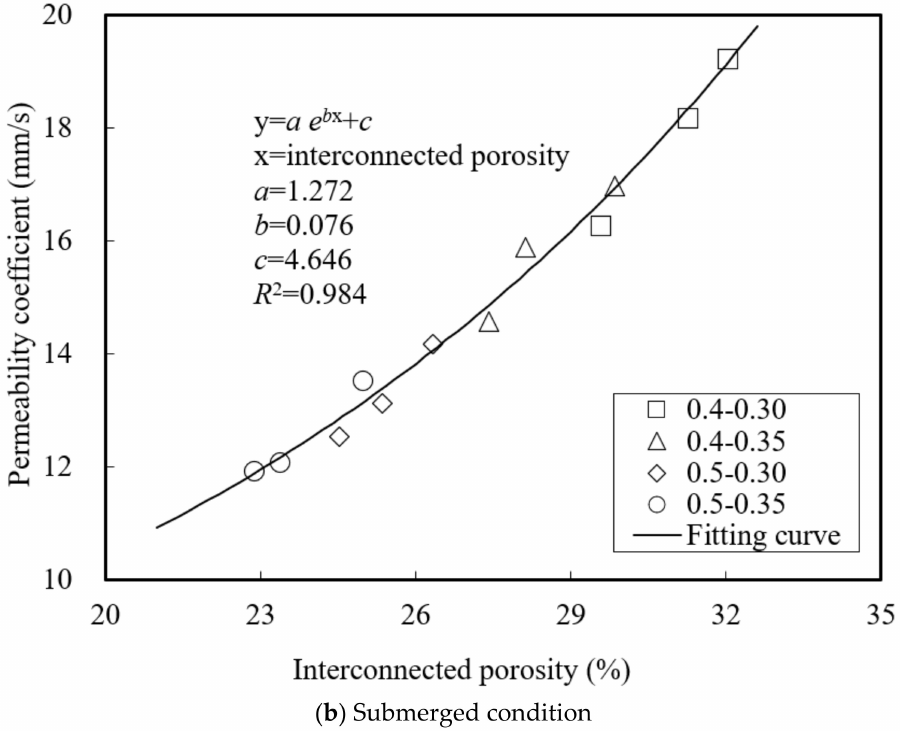
Figure 13. Interconnected porosity versus permeability